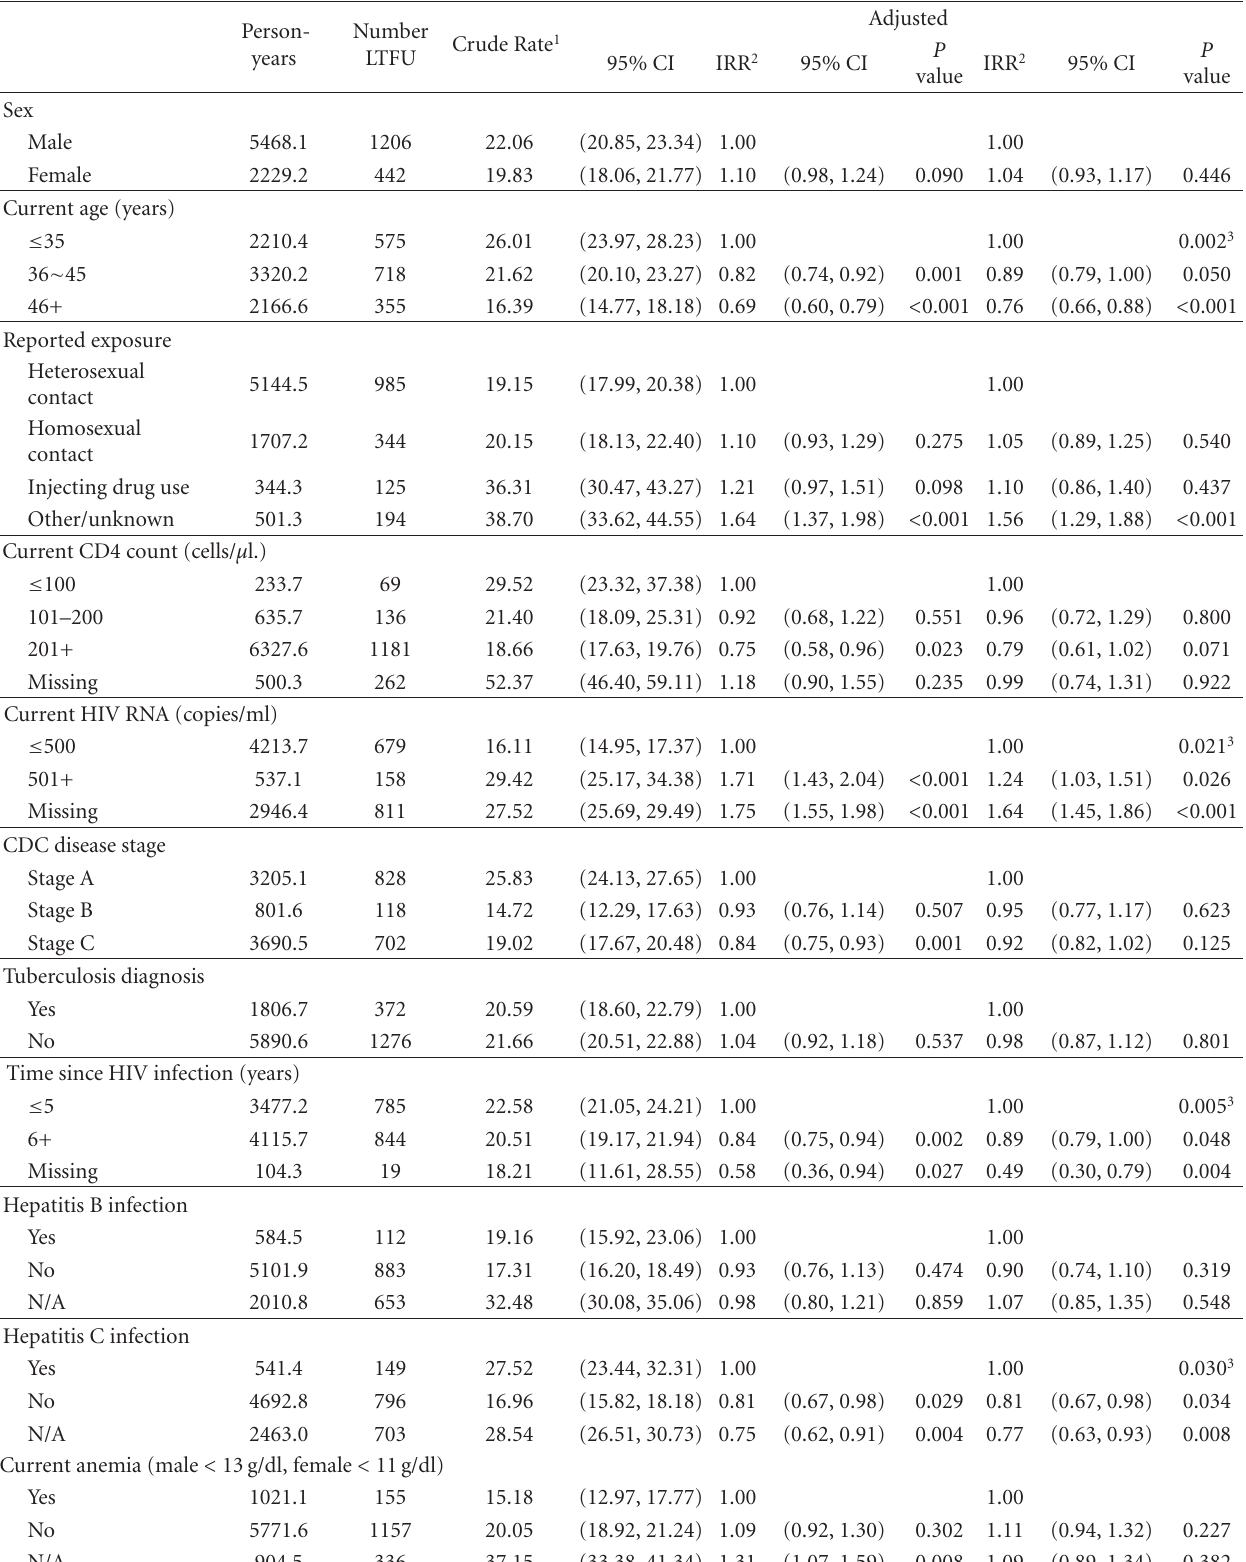
Table 3: Factors associated with permanent or temporary LTFU, defined as no clinic visit for 180 days, among all patients under followup.